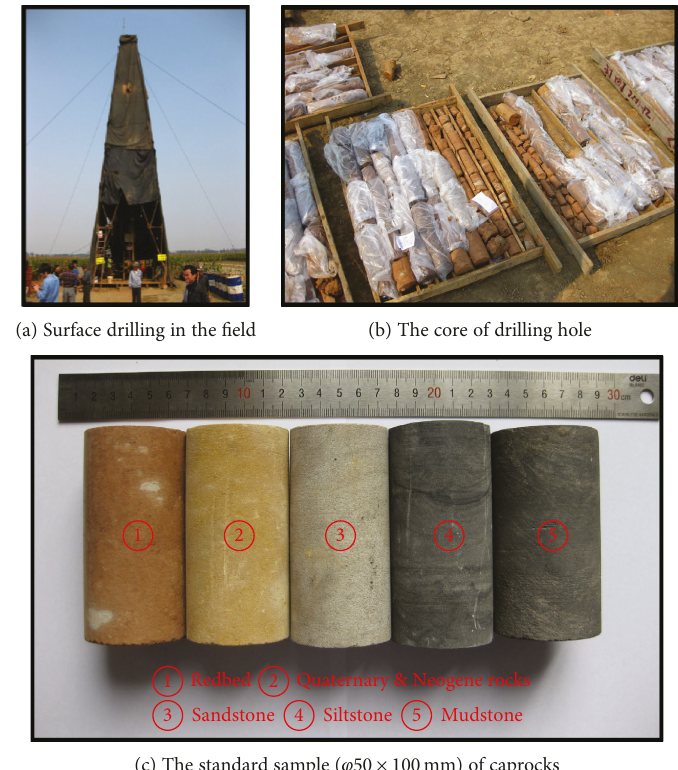
Figure 3: Field sampling process of caprocks and the standard sample